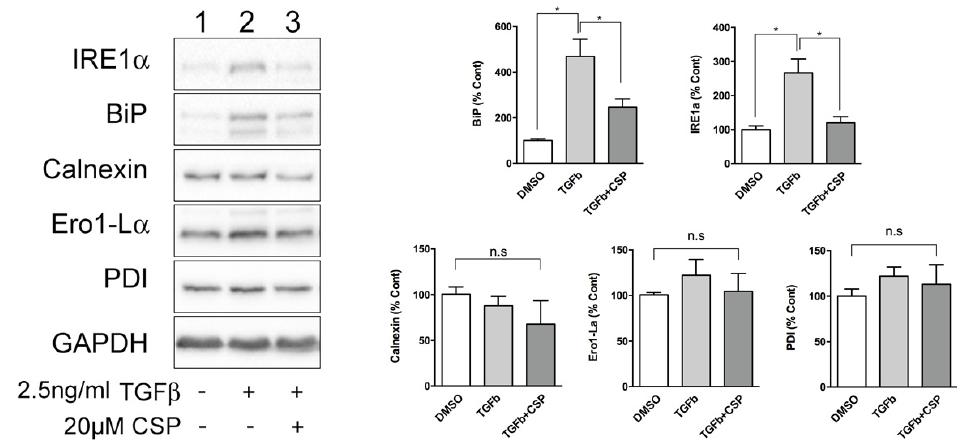
Figure 2. CSP reduced TGF β -induced ER stress in hIPF-Lfs. Expression of unfolded protein response (UPR) markers in hIPF-Lfs. hIPF-Lfs were treated with TGF β in the presence or absence of CSP. Whole cell lysates were subjected to Western blotting for IRE1 α , BiP, calnexin, Ero1-L α , PDI, and α SMA. The expression of the UPR markers was normalized to that of glyceraldehyde 3-phosphate dehydrogenase (GAPDH) and is shown as mean ± SEM from three independent experiments. GAPDH was used as an internal control to normalize protein expression. * p values by one-way ANOVA with the Tukey’s multiple comparisons test ( p < 0.05).